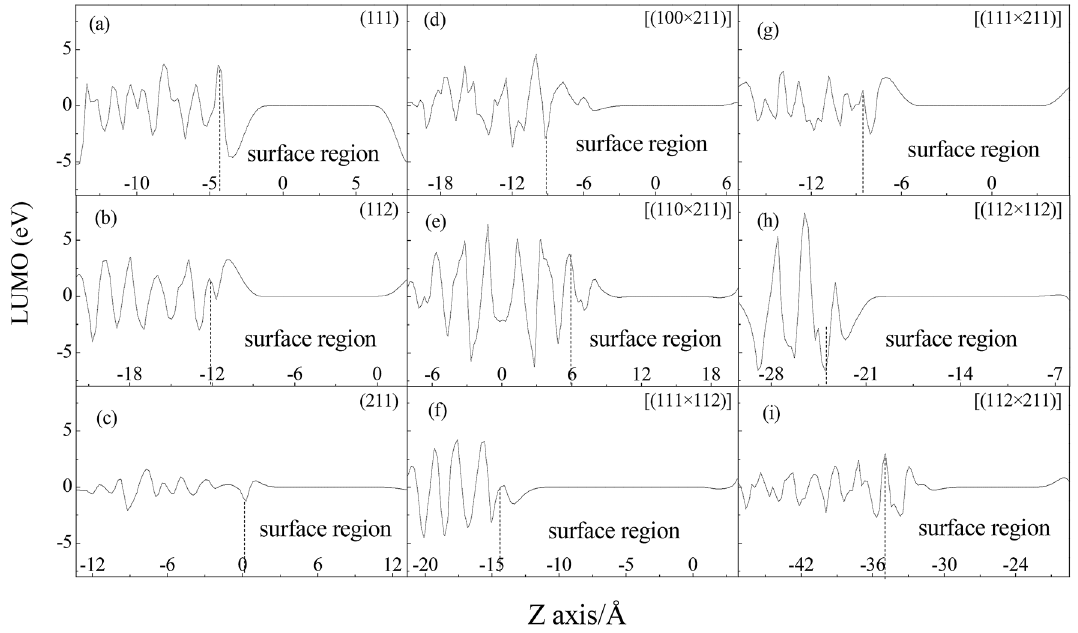
Figure 6. LUMO of MnO 2 bulk surface and microfacet